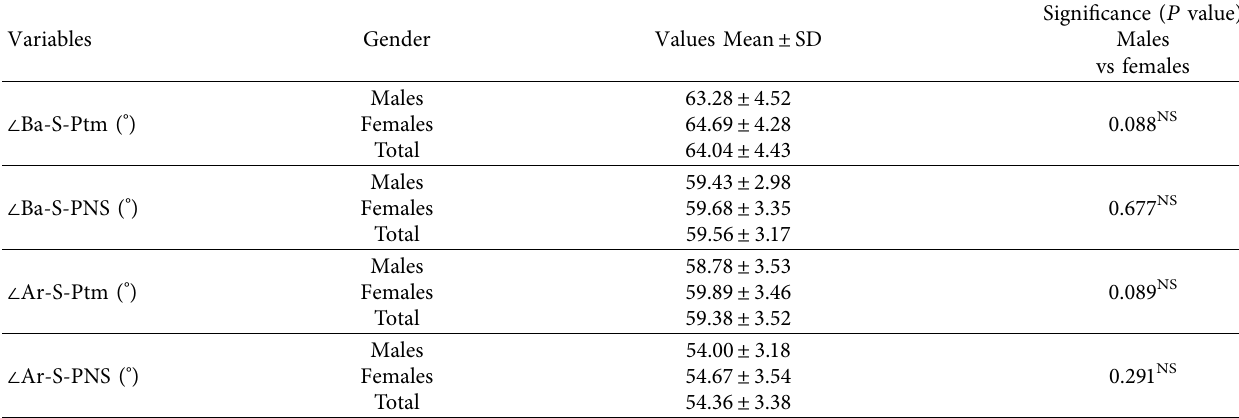
Table 3: Various angular parameters used for the determination of normal vertical positions of S